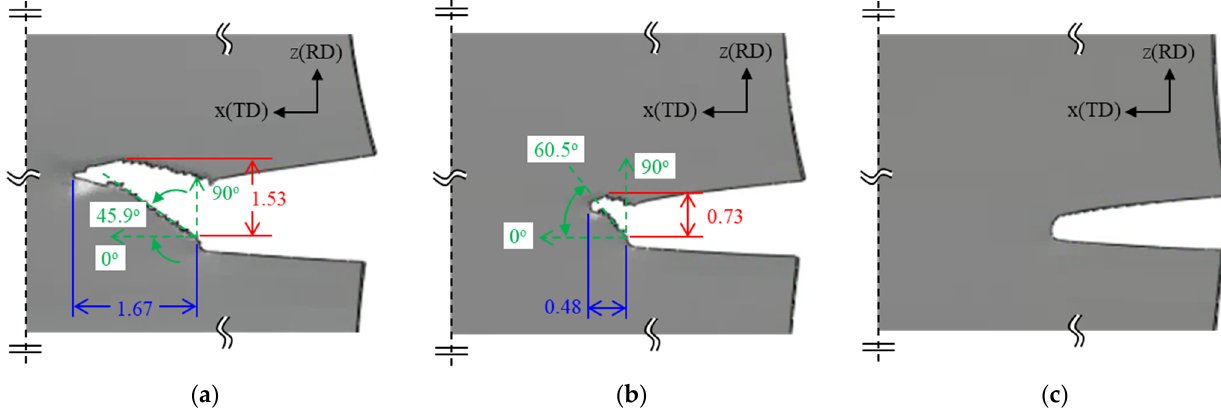
Figure 10. Edge cracking behavior when roll-bending ratio (L 2 /R 2 ) changes ( a ) L 2 /R 2 = 0.18 ( b ) L 2 /R 2 = 0.09 ( c ) L 1 /R 1 = 0 and L 2 /R 2 = 0, which correspond to perfectly flat rolling. Variables L 1 , L 2 , R 1 , and R 2 are explained in Figure 6.